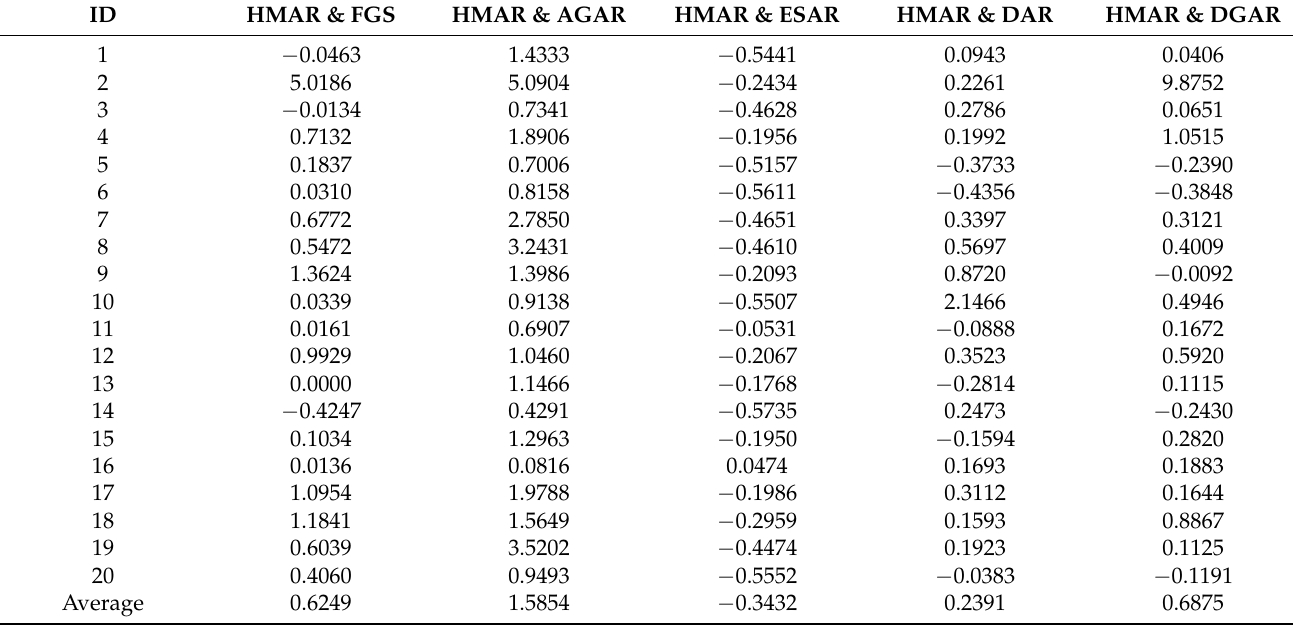
Table 4. The changing ratio related to stability of reducts based on Nogueira’s